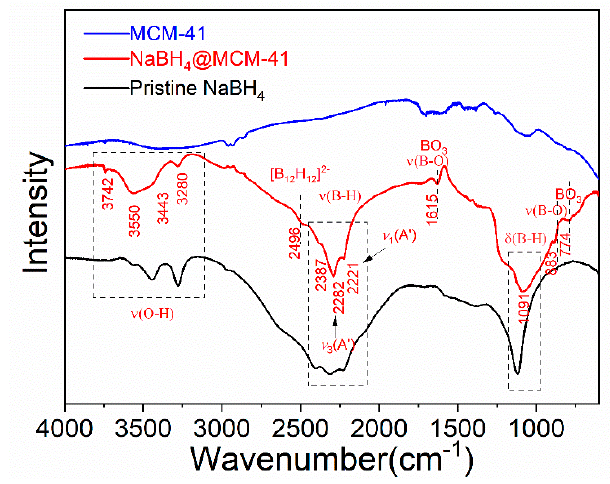
Figure 2. FTIR analysis of NaBH 4 @MCM-41 and pristine NaBH 4 .